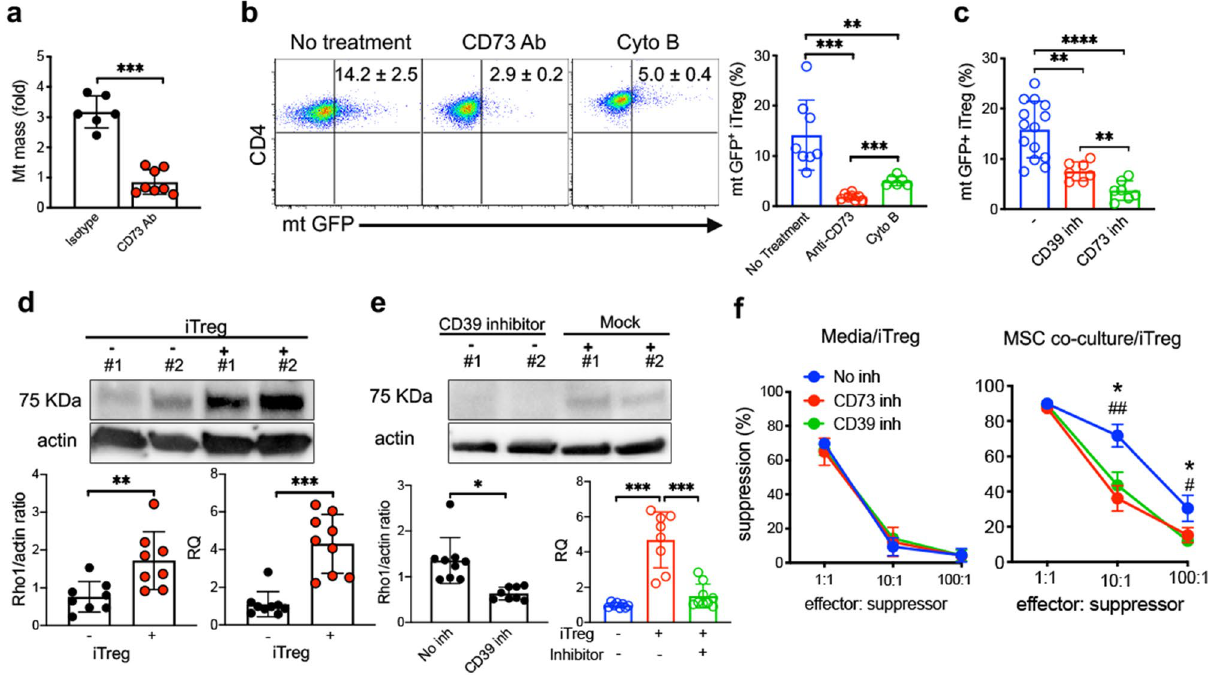
Figure 5. CD39/73 signaling induces MSC mitochondrial transfer to iTregs during IL-2 driven expansion. ( a ) Mitochondrial quantity was measured from IL-2/media or MSC co-culture expanded iTregs by RT-PCR ( n = 6–8). Anti-CD73 antibody (10 μg ml −1 ) was added in MSC co-culture. Cells were collected at 72 h after mtGFP lentiviral transduced MSC co-culture. ( b ) Flow analysis of mtGFP + iTregs in anti-CD73 blocking and cytochalasin B treatment. Cells were stained with CD4 antibody in order to identify iTregs at 72 h. ( c ) Analysis of mtGFP + CD4 + iTregs after incubation with CD39 (100 nM) and CD73 (100 nM) inhibitor treated MSC ( n = 7–14). Representative flow plot, gated for CD4 + iTreg cells after MSC co-culture. ( d ) Protein and RNA expression of Miro1 in MSC were measured after co-culture with iTreg. ( e ) After co-culture in the presence of CD39 inhibitor ( n = 8–9). The image intensities for western blots were normalized to beta actin. Data are representative of 3–4 different experiments. ( f ) Effect of CD39 and CD73 inhibitors on suppressive functions of iTreg during MSC co-culture expansion. Inhibitor was added to iTreg and MSC co-culture. Data are representative of n = 3 independent samples. * p < 0.05, ** p < 0.01, *** p < 0.001, **** p < 0.0001 paired t test. See also Supplementary Fig. Fig. 6b,c). As CD39 and CD73 calibrate purinergic signals delivered to immune cells through the conversion of ADP/ATP to AMP and AMP to adenosine, respectively 44, 45 , we inhibited each pathway and observed reduced mtGFP + iTregs (Fig. 5c and Supplementary Fig. 6d).